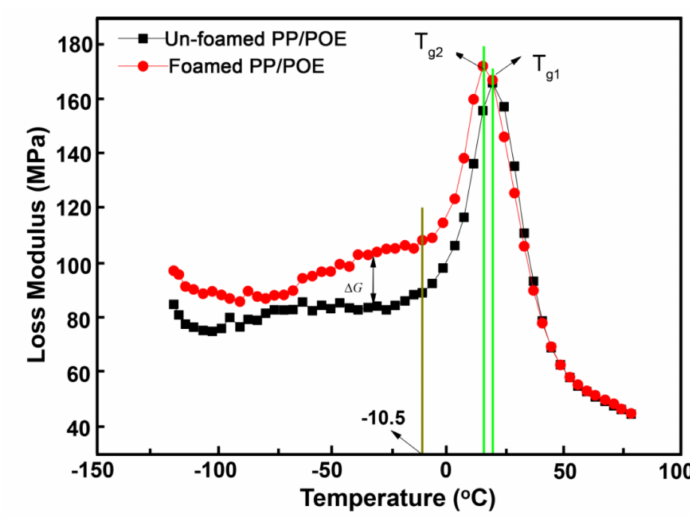
Figure 10. Loss modulus of the foamed and unfoamed PP (POE, 20 wt %) composites at different